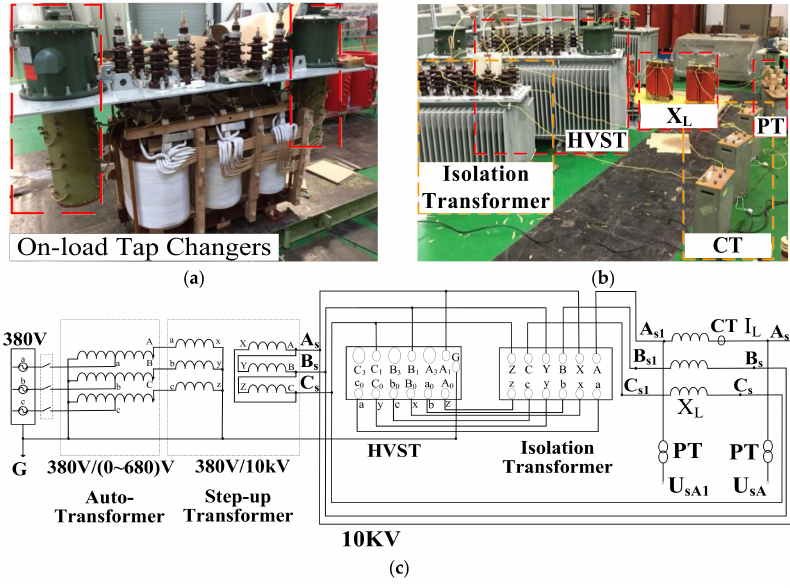
Figure 15. The 10 kV HVST device and the corresponding experimental platform. ( a ) The HVST before encapsulation; ( b ) The experimental platform; ( c ) The equivalent circuit of the experimental